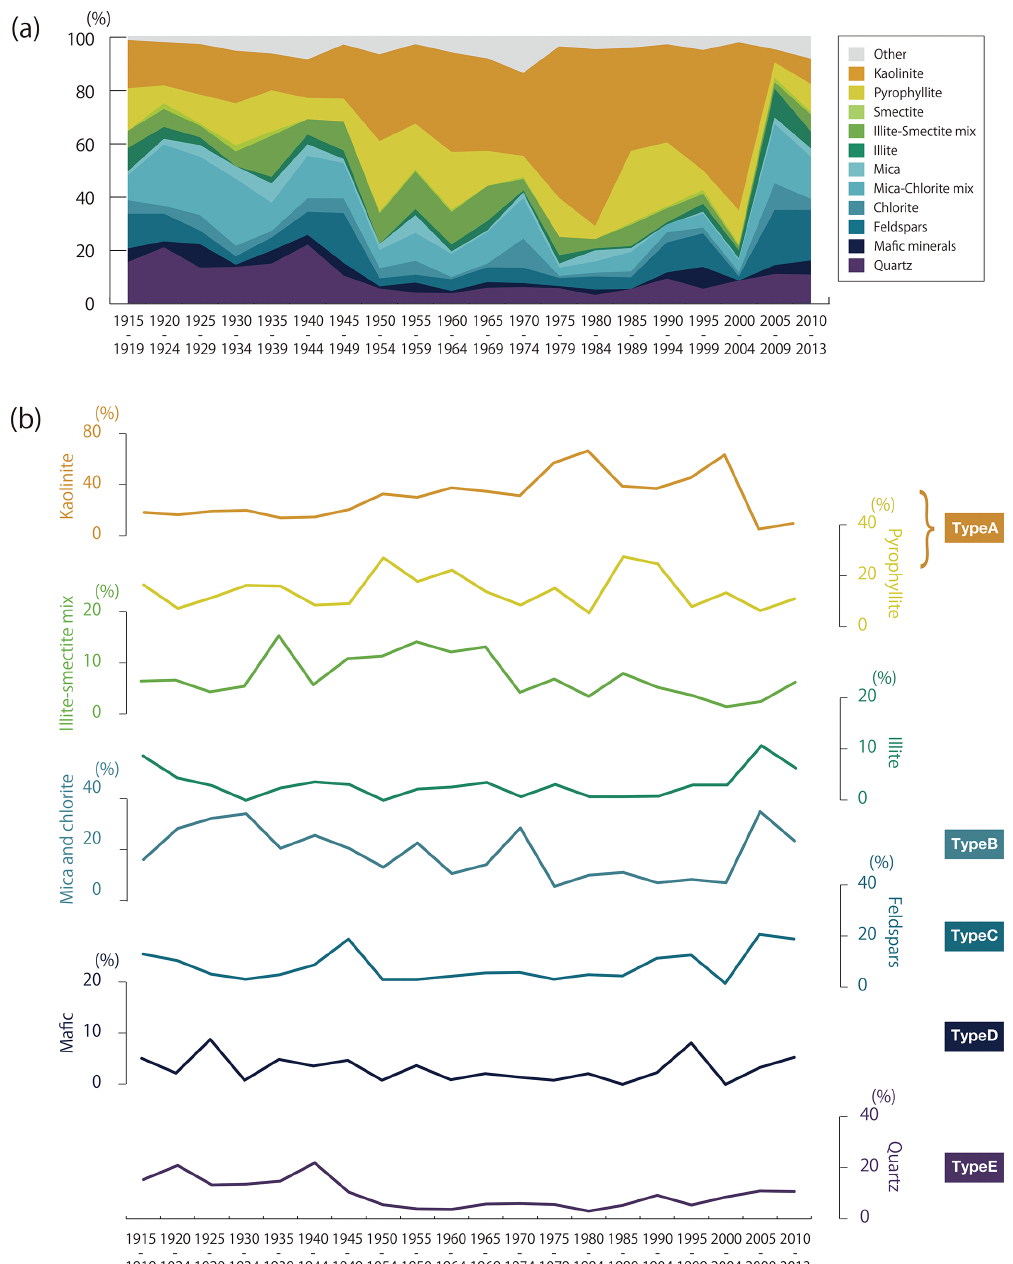
Figure 7. Variations in the silicate mineral records in the ice core in 5-year resolution. (a) Mineral composition and (b) proportion of each mineral. Mica and chlorite composed of mica, mica–chlorite mix, chlorite, and feldspars composed of Na/Ca-feldspar and